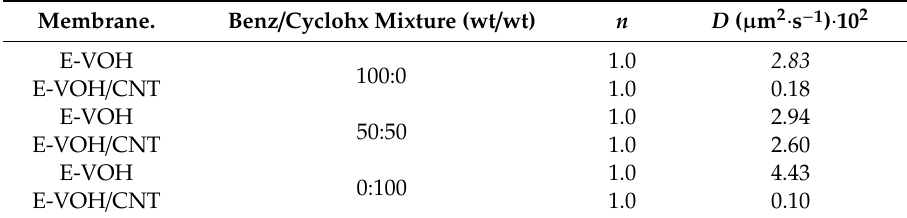
Table 6. Di ff usivity parameters of benzene and cyclohexane in E-VOH membrane measured at 25 ◦ C.